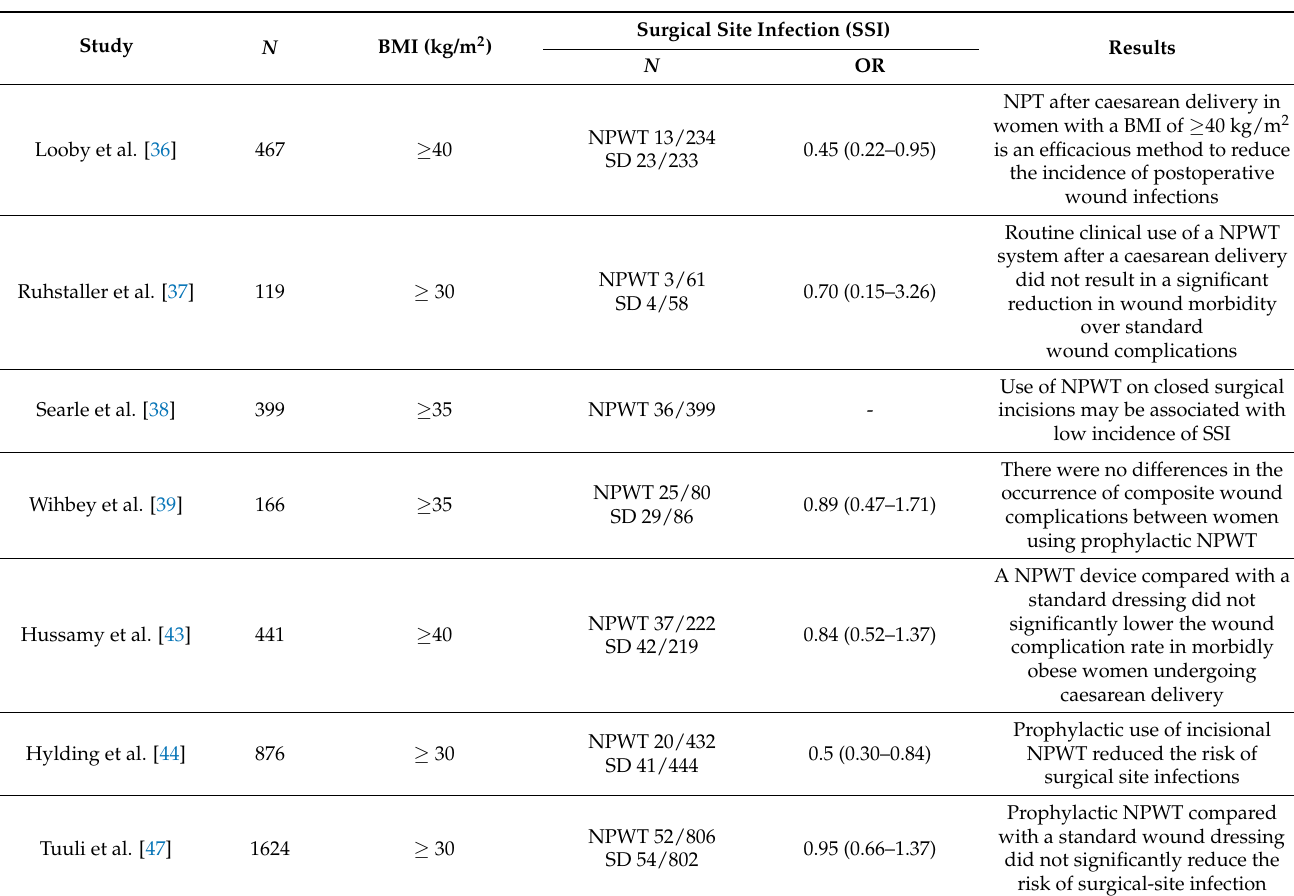
Table 5. Results of studies included in the review and meta-analysis describing the role of prophylactic negative pressure therapy in surgical site